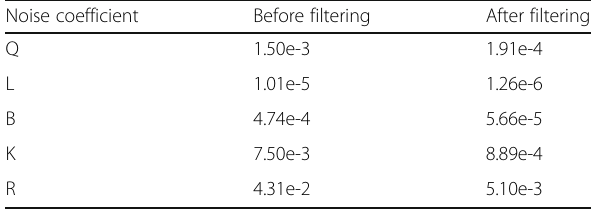
Table 2 Stochastic noise coefficients before and after Kalman filtering